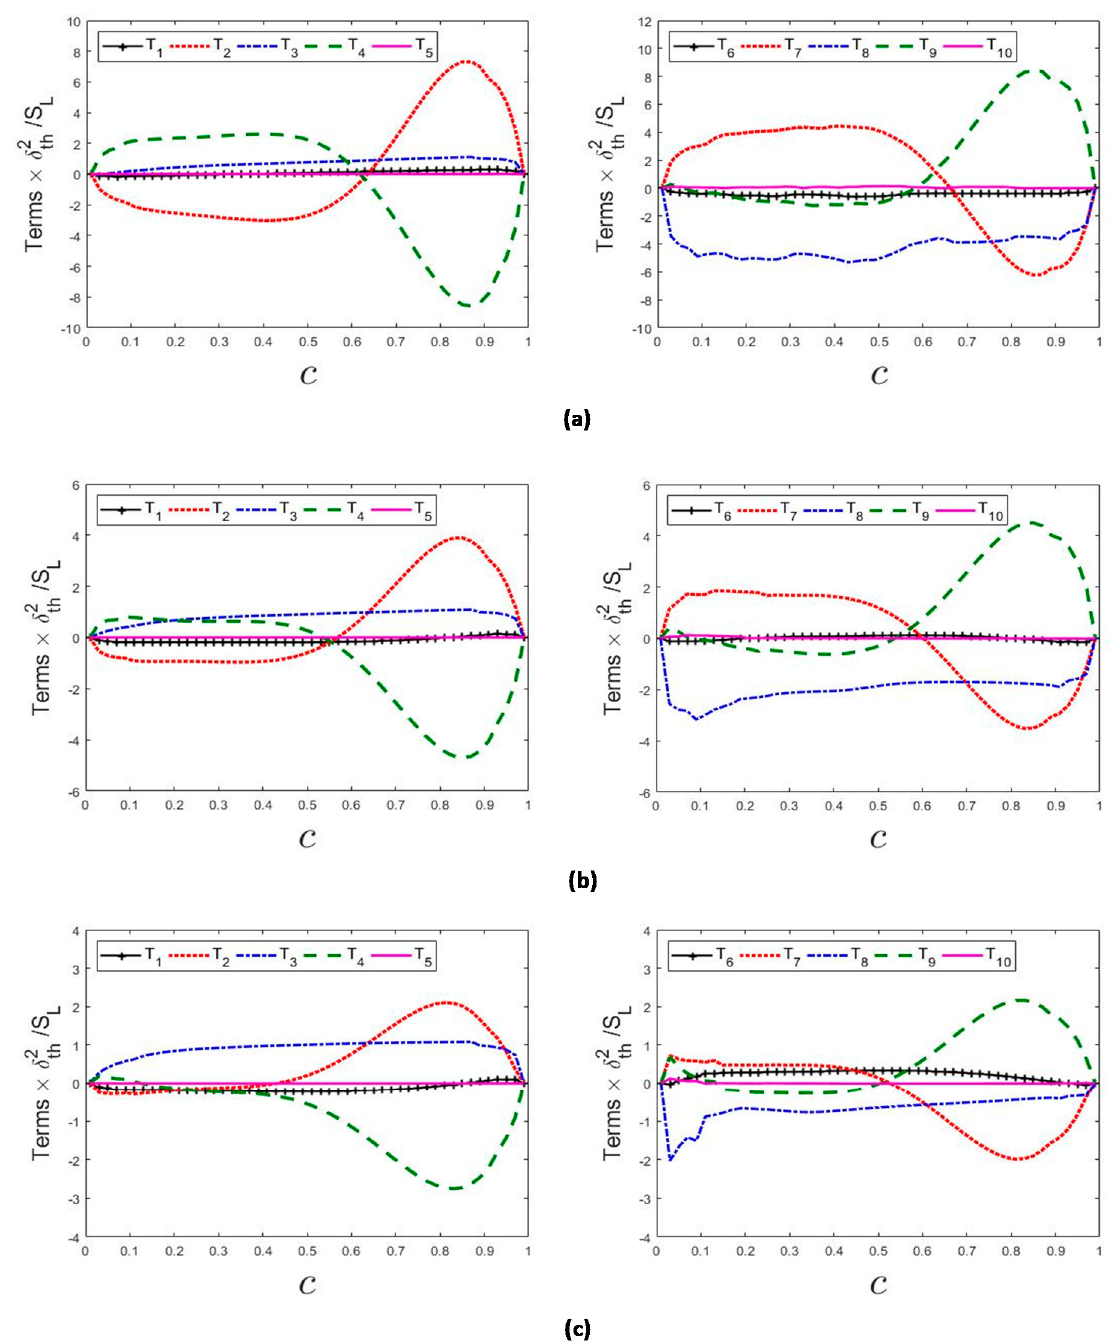
Figure 4. Profiles of the normalised mean values of the fluid flow induced terms (i.e., T 1 − 5 × δ 2 / S L ) (left column) and flame propagation induced terms (i.e., T 6 − 10 × δ 2 / S L ) (right column) of the curvature transport equation conditional upon c for cases ( a – c ) Le = 0.8, 1.0 and 1.2. The mean value of the curvature flow stretching term T 3 × ( δ 2 / S L ) = − ( S ij n j , i )( δ 2 / S L ) is found to be positive throughout the flame brush in all cases considered here. The magnitude of T 3 becomes comparable to T 2 for the Le = 1.2 case but its magnitude in comparison to T 2 remains small in the Le = 0.8 case. Using ( x T 1 , x T 2 ) as the local principal axes along the tangential directions on a given c isosurface, the curvature flow stretching term can be expressed as T 3 = − ( S 11 κ 1 + S 22 κ 2 ) , where S 11 and S 22 are the tangential strain rates along axes x T 1 and x T 2 , respectively. The mean tangential strain rate a T = S 11 + S 22 assumes positive values throughout the flame front for all flames